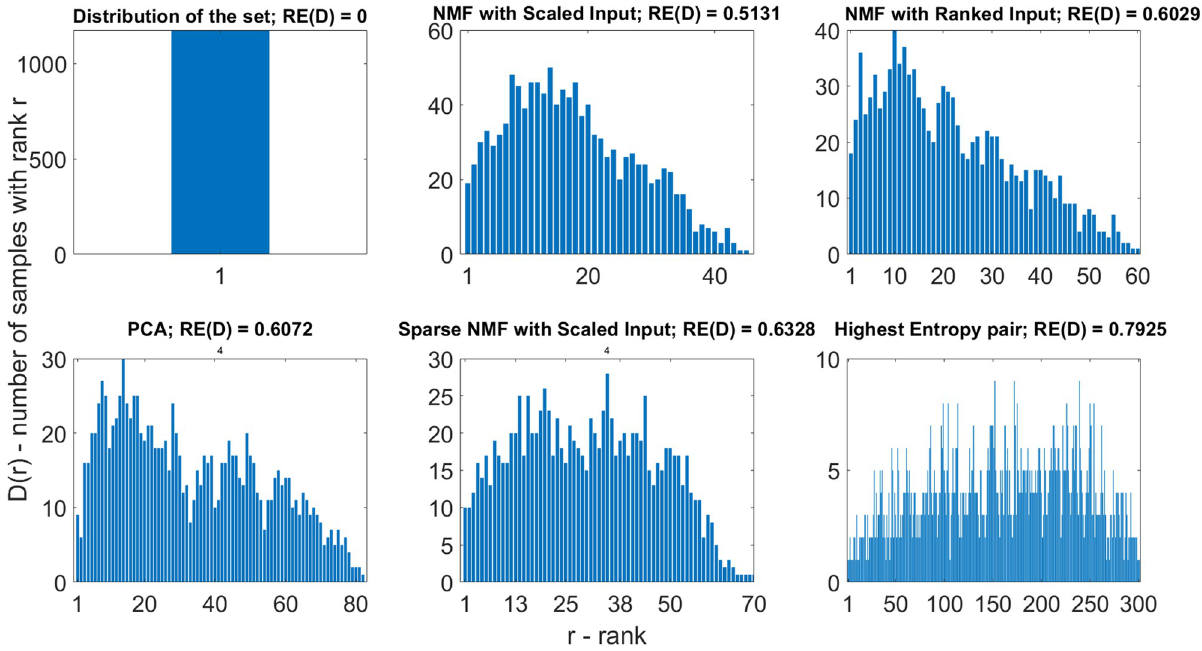
Fig 15. Relative entropies of the methods. The smaller the range of the y-axis (solutions with ranks), the bigger the range of the x-axis (ranks) is, and vice versa . Data with high REs have more ranks and fewer solutions with the same rank. The histograms represent the saturation of the Pareto fronts. From the viewpoint of Entropy, PCA and sparse NMF performs more efficiently than NMF. As the evaluation based on PCA consists of more ranks, the evaluation of the sparse NMF clarifies a more specific set of optimal solutions, which SRD validates. Furthermore, bimodal distributions can be observed (or suspected), except in the top left